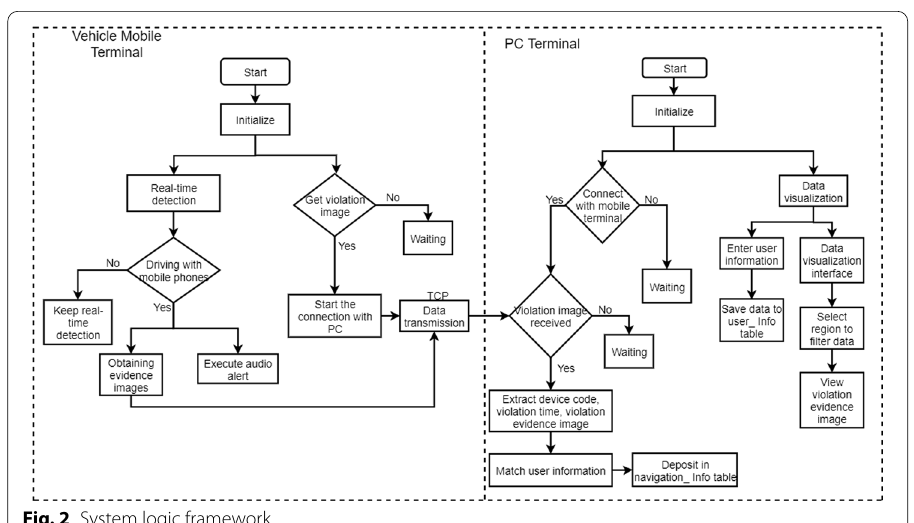
Fig. 2 System logic